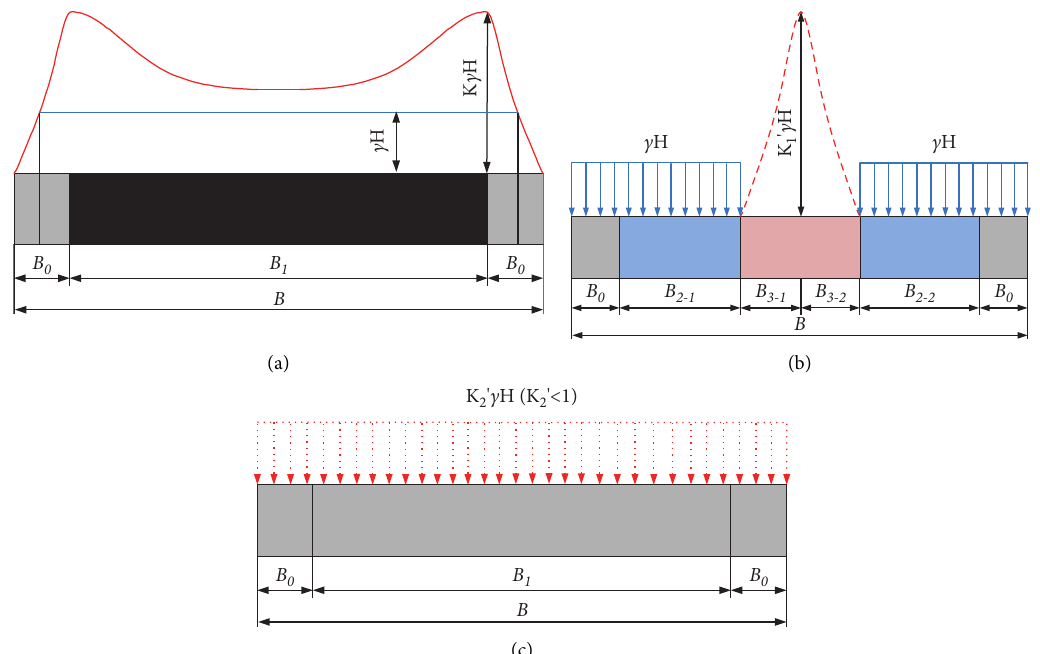
Figure 11: Mechanical model of the hydraulic cutting of the residual coal pillar. (a) Before coal pillar failure. (b) In the process of coal pillar failure. (c) After coal pillar